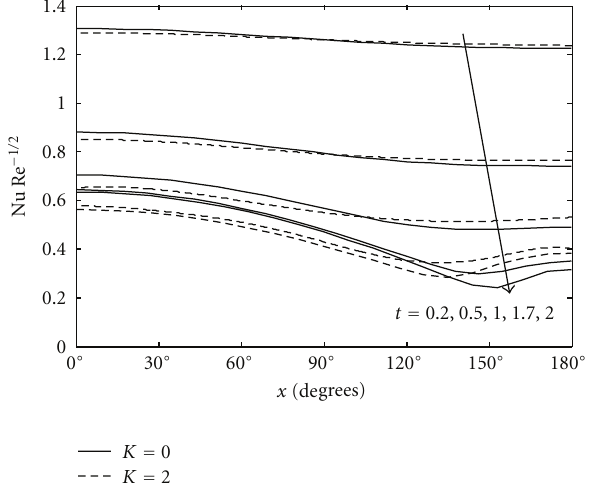
Figure 8: Variation of the skin friction coe ffi cient with x for K = 0, 2 and for various values of t when Pr = 1, α = 1 . 25 (assisting flow) and n = 0.